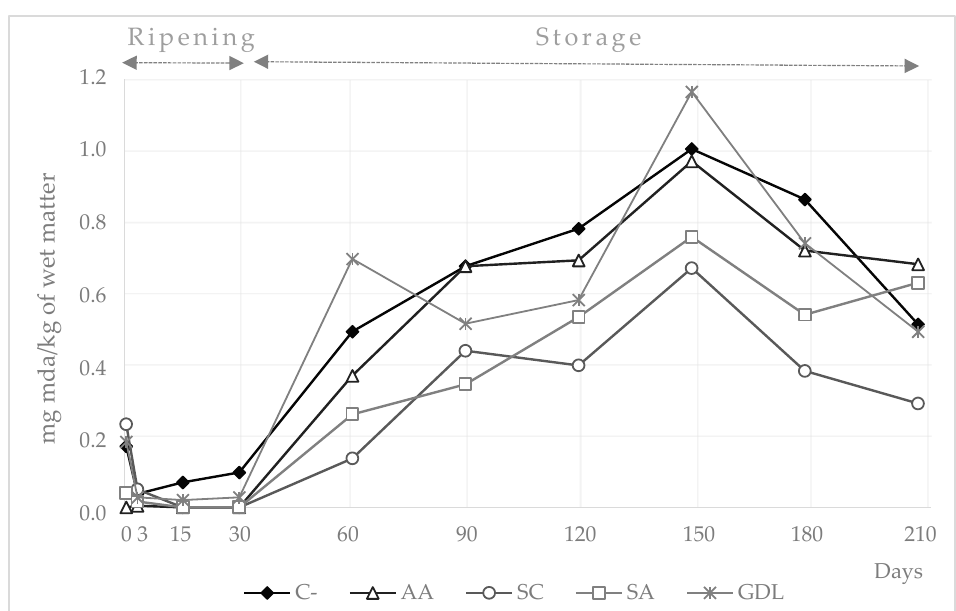
Figure 3. TBARS values (mg MDA/kg of wet matter) in sausages manufactured with different reducing agents added during ripening and storage periods (days). C- = negative control; AA = ascorbic acid; SC = starter culture; SA = sodium ascorbate; GDL = glucono-delta-lactone.